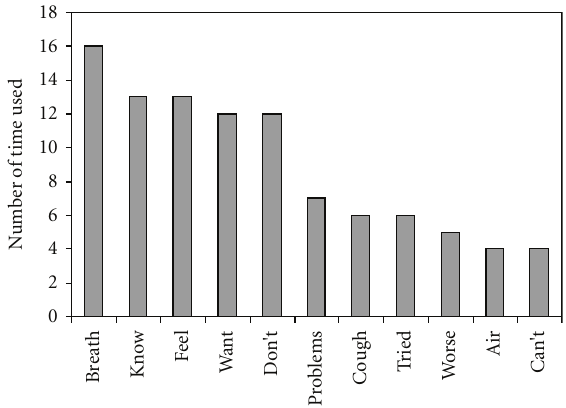
Figure 1: Most frequently used words during focus groups.